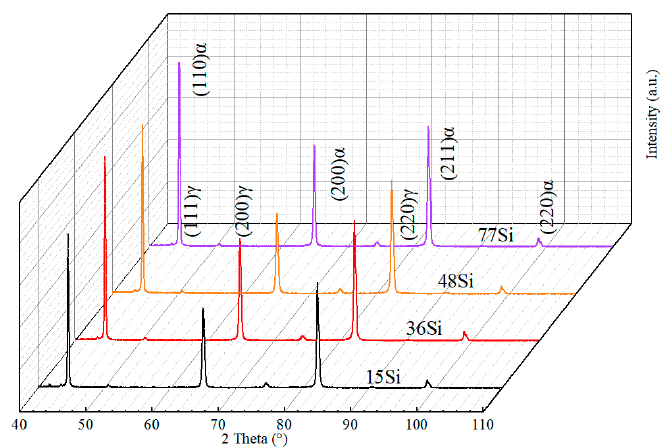
Figure 10. XRD spectra of samples with varying silicon content.